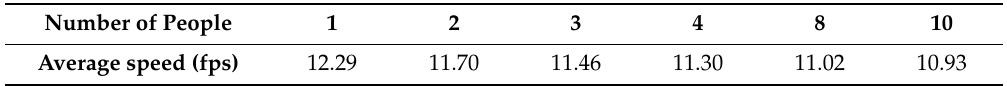
Figure 9. Action recognition results where action classes are ( a ) Eat_meal, Headache, Fall-down ( b ) Stand_up, Headache, Stomachache. ( b ) Stand_up, Headache, Stomachache. Table 2. Execution speed of the proposed system for various numbers of Table 2. Execution speed of the proposed system for various numbers of people.